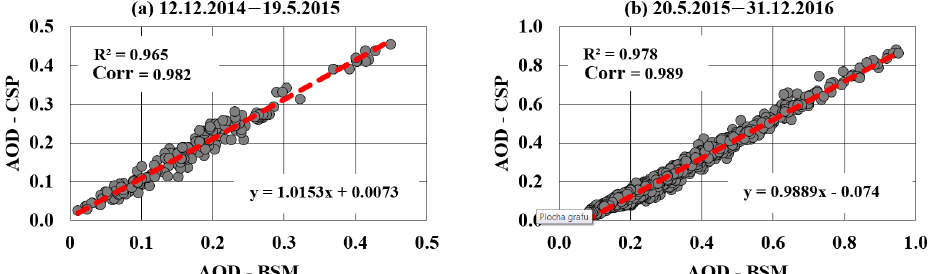
Figure 8. Comparison of AOD values for the wavelength of 320nm obtained by means of the BSM and the Cimel sun photometer